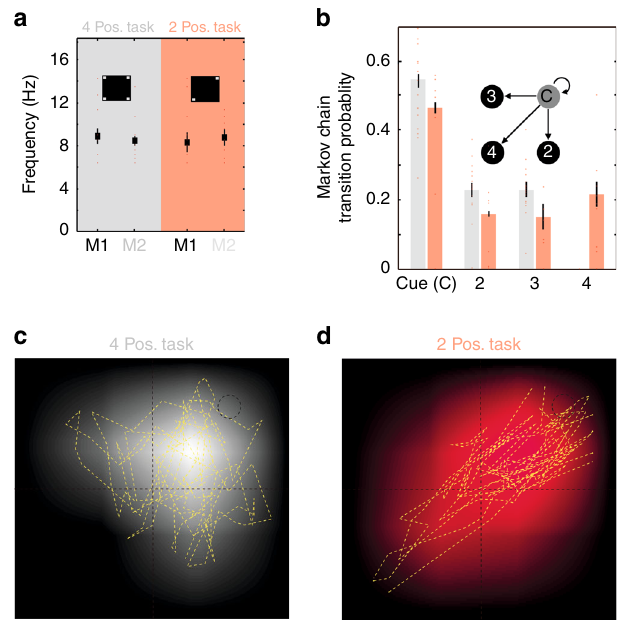
Fig. 10 How PFC attentional spotlight rhythmically explores space depends on task context. a 7 – 12 Hz oscillation peak in PFC attention information in a four (gray) or two (red) cued positions target detection task, for monkeys M1 (black) and M2 (gray), over all sessions (±s.e.), individual data points plotted in red. b Markov chain probability (±s.e.) of the attentional spotlight to stay at the cued quadrant [C], to transition to the same hemi fi eld uncued quadrant [2], to transition to the opposite hemi fi eld uncued quadrant [3] or to transition to the diagonally opposite uncued quadrant [4], in the four (gray) or two (red) cued positions target detection task. c Single trial example of PFC attentional spotlight exploration (10 ms resolution) during the cue to target interval, in a four cued positions target detection task, superposed onto the Markov chain probability map for this cued condition, individual data points plotted in red. Cue was presented in the upper right quadrant. d Same as in ( c ) for a two cued positions target detection task.